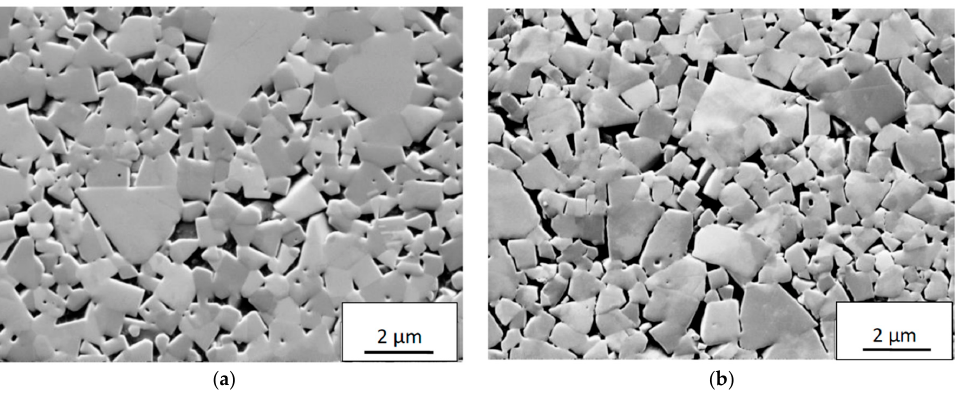
Figure 19. SEM images illustrating the degradation of the cemented carbide structure in the plastically deformed region (20 μ m below the surface in the centre of the flank wear land). ( a ) Undeformed WC-Co microstructure; ( b ) deformed WC-Co microstructure. Cutting speed: 90 m/min, feed rate: 0.2 mm/rev., time: 1 min).